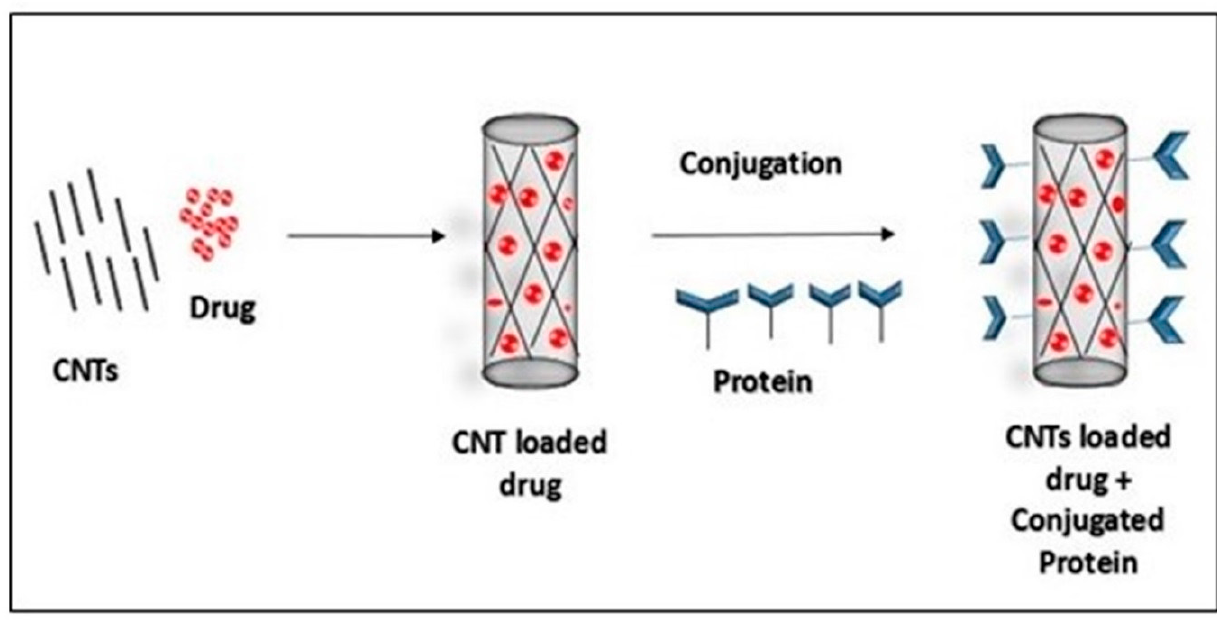
Figure 3. Scanning electron micrograph of purified CNTs (image reproduced with permission from reference) [23].